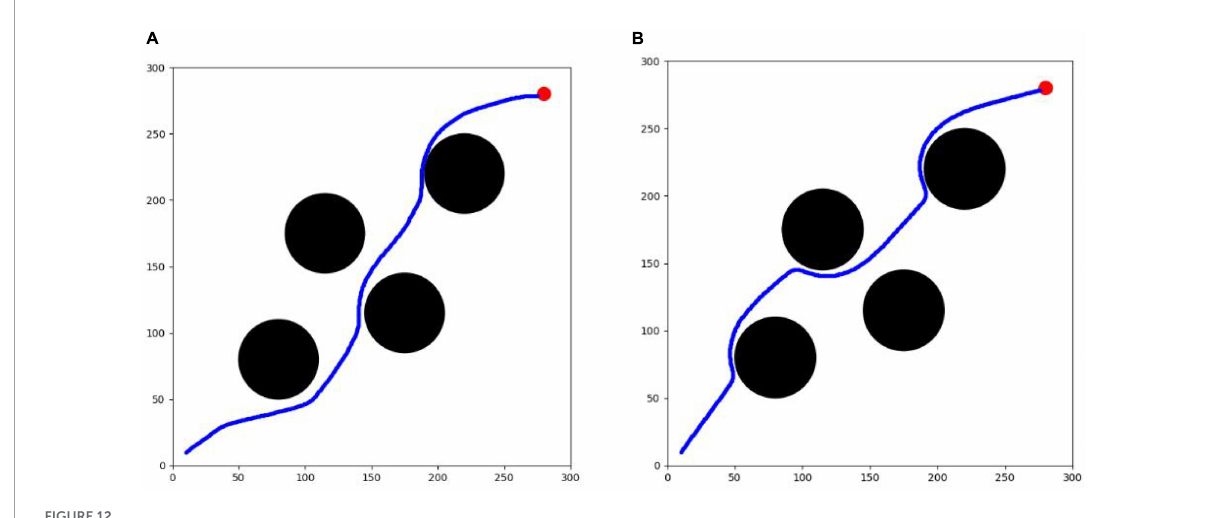
FIGURE12 UAV path map. (A) SAC algorithm. (B) TD3